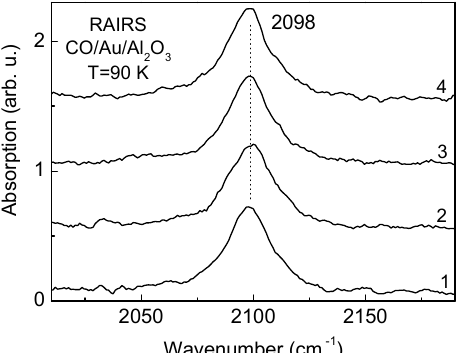
Figure 3. RAIR spectra in CO stretch region, obtained after 100 L-exposure of CO of alumina supported Au overlayers at a coverage of 0.7 MLE, cooled down to 90 K. Alumina film thickness: (1)—2 mL; (2)—4 mL; (3)—6 mL; (4)—8 mL.